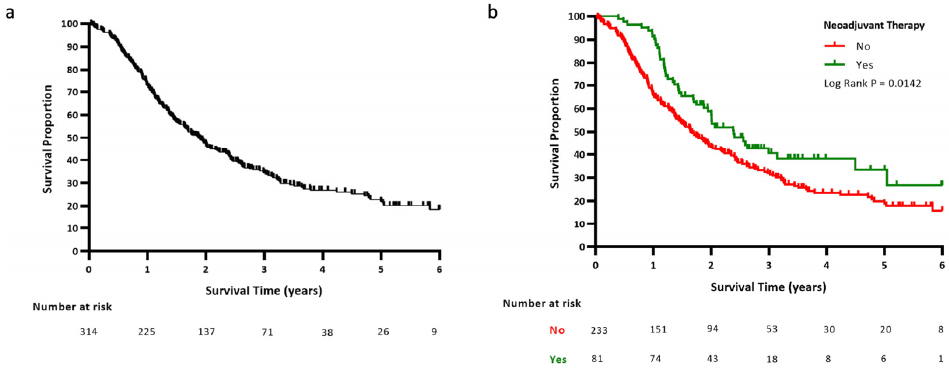
Figure 1. Kaplan–Meier OS curves for all patients combined ( a ) and for those who received NAT versus no NAT ( b ).